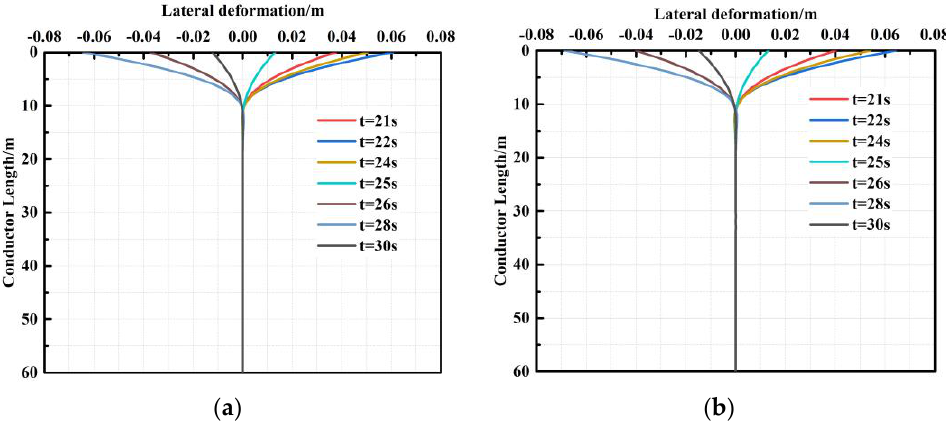
Figure 8. Simulation results of the lateral deformation, where ( a ) is the result calculated by the con- tact surface model and ( b ) is that calculated by the Goodman contact element model.